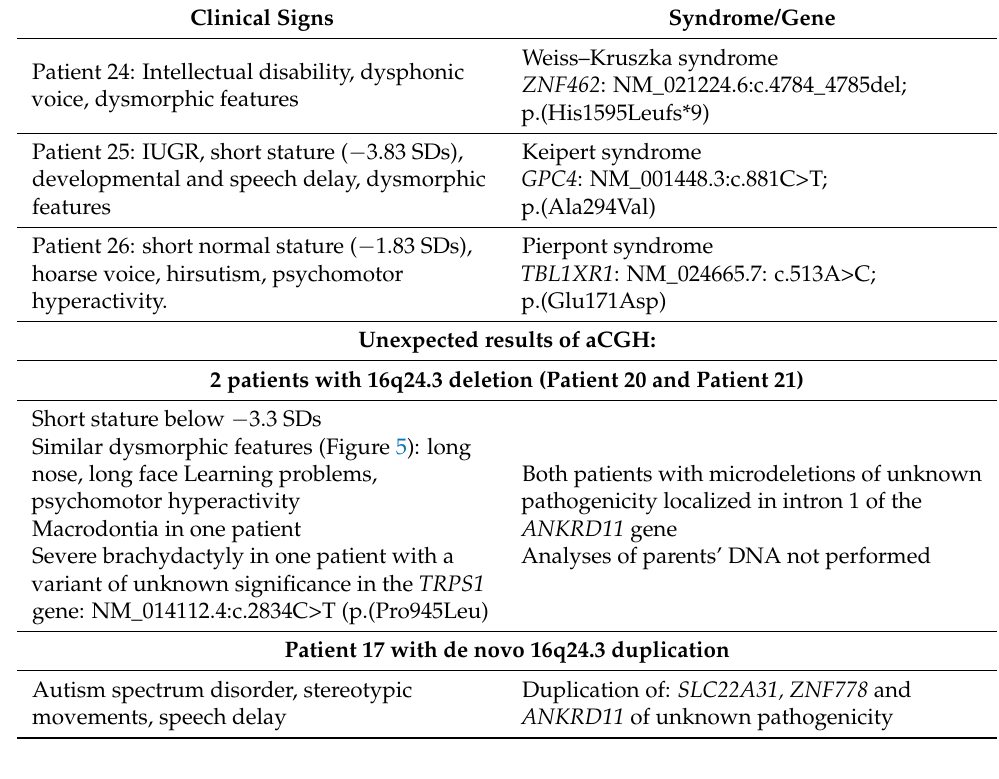
Table 3. Unexpected results of genetic analyses performed in patients clinically suspected of the